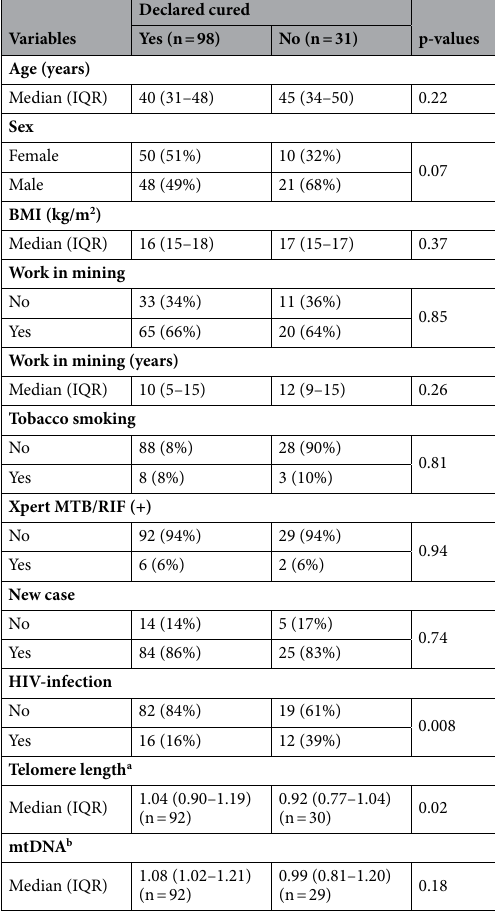
the ratio of ND1 copy number to single-copy gene number relative to the average ratio of the entire sample set (n = 121). p-values refer to difference between declared cured vs not declared cured (without